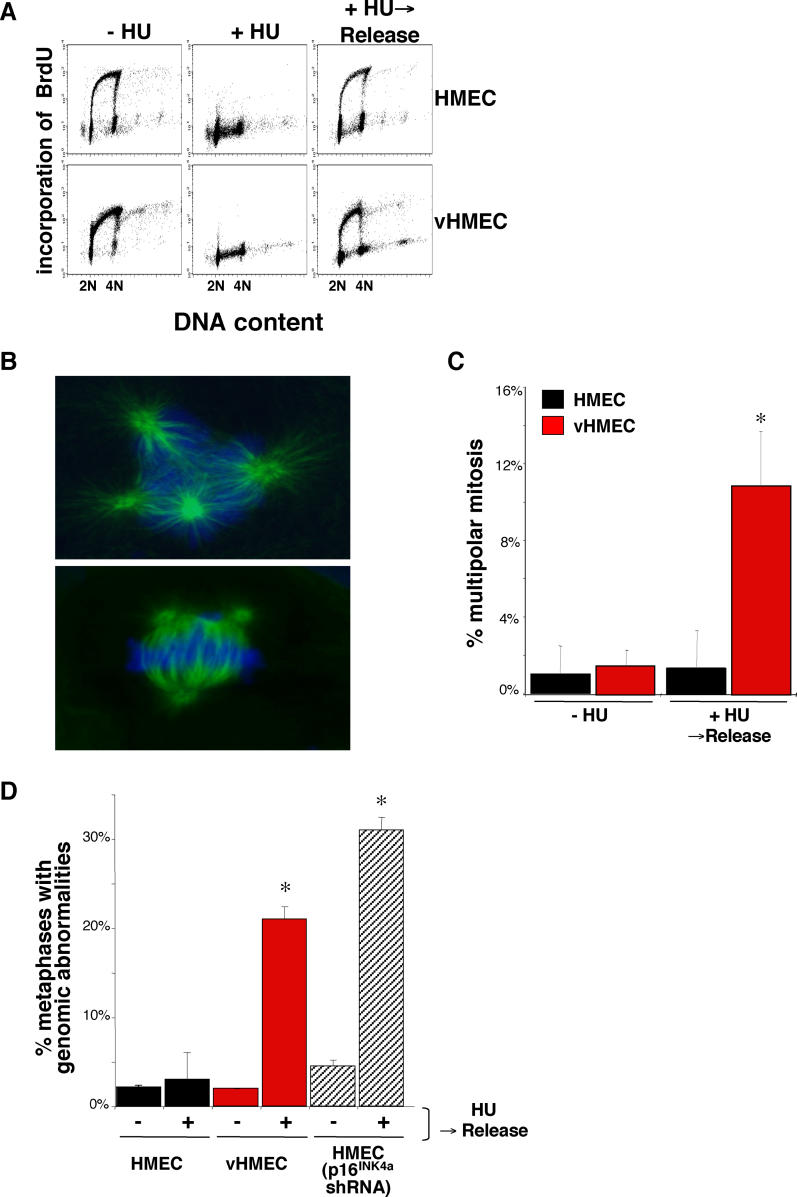
Supernumerary Centrosomes Produce Multipolar Spindles and Correlate with Aneuploidy(A) BrdU incorporation of HMECs (top) and vHMECs (bottom). Cell cycle analysis were performed using BrdU incorporation for cells that were untreated (−HU), treated for 48 h with HU (+HU), or treated for 48 h with HU, followed by release from HU treatment for 7 to 8 d (+HU → release). DNA replication resumes following release from 48 h of HU treatment.(B) Microtubule nucleation sites were determined by immunocytochemistry with an antibody recognizing γ-tubulin.(C) Analysis of HMECs (black: RM9 and RM26 [less than 4 PD]) and vHMECs (red: RM15 [25 PD], RM16 [13 PD]) for multipolar mitosis in untreated (−HU) or exposed to HU followed by release from HU treatment (+HU → release).(D) Analysis of HMECs (black: RM9 and RM15 [less than 5 PD]) and vHMECs (red: RM9 [21 PD], RM16 [17 PD]), HMECs infected with p16INK4a shRNA (gray) for genomic abnormalities in untreated (−HU) or exposed to HU followed by release from HU treatment (+HU → release). Types of chromosomal abnormalities represented include aneuploidy, structural abnormalities, and telomeric associations. Analysis included at least 100 metaphases. *Statistical significance (p < 0.005) based on comparison of −HU and +HU → release experiments.